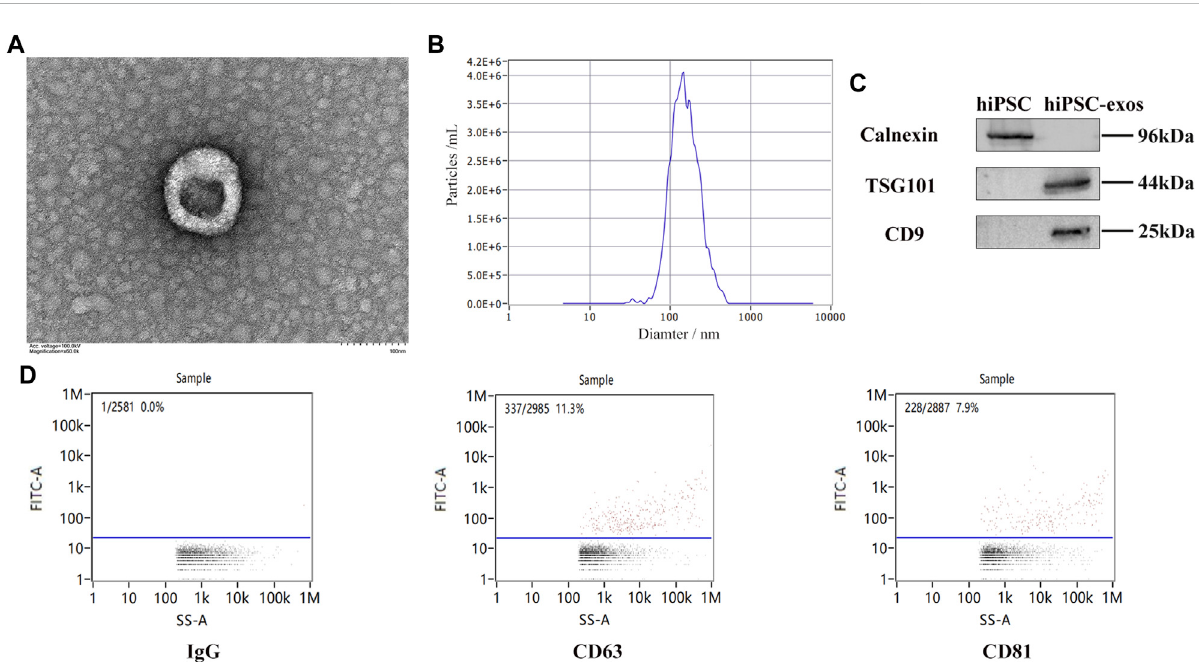
Characterization of exosomes derived from hiPSCs. (A) Cup-shaped structure of hiPSC-exosomes under a transmission electron microscope. (B) ParticlesizedistributionmapofhiPSC-exosomesgeneratedbynanoparticletrackinganalysis. (C) Speci fi cproteinmarkers(CD9andTSG101)and negative protein marker(Calnexin)in hiPSC-exosomesdetected bywestern blotting. (D) Isotype control IgG and speci fi cmarkers(CD63,and CD81) in hiPSC-exosomes detected by a Flow